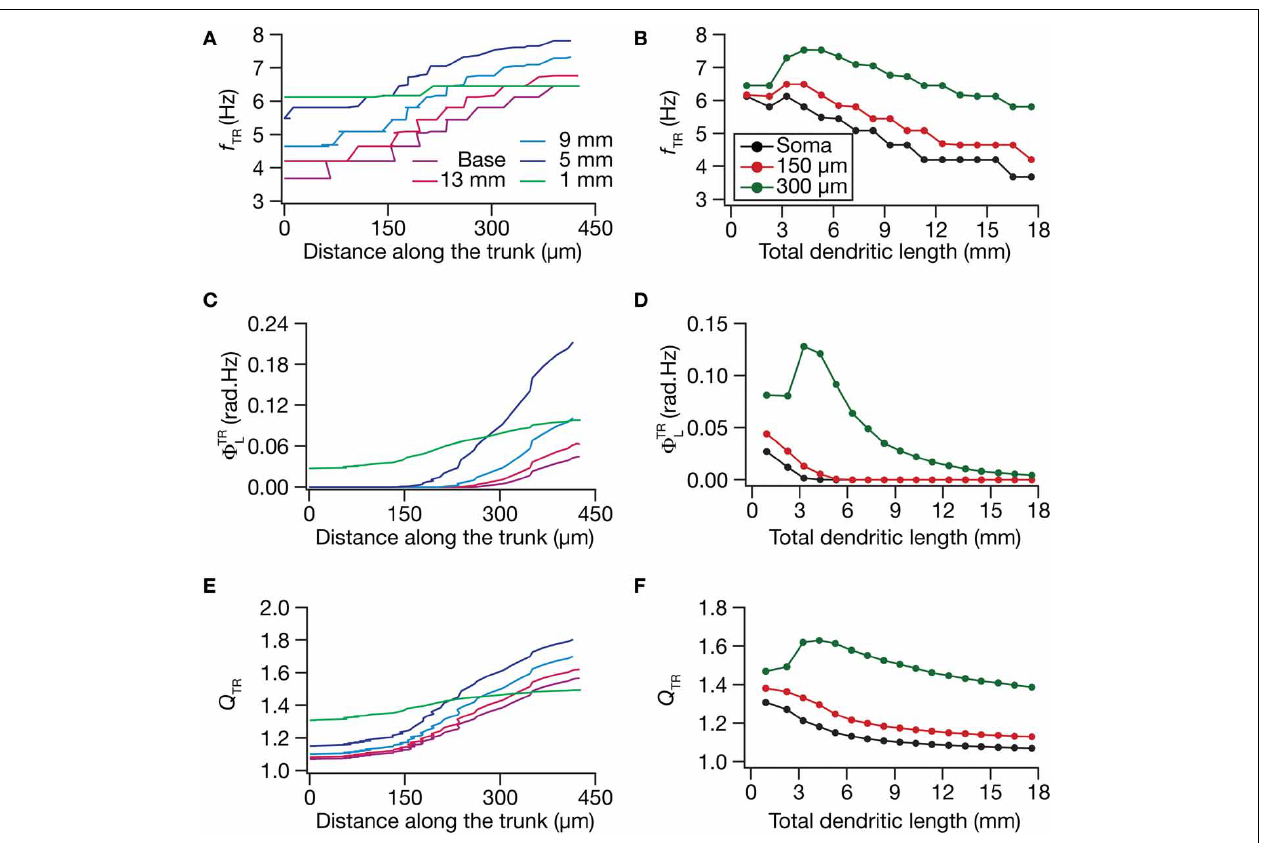
FIGURE 6 | Functional maps of several HCN - channel-dependent transfer impedance measurements were critically regulated by dendritic atrophy. (A,B) Transfer resonance frequency ( f TR ) plotted as functions of distance from the soma ( A ; for 5 different pruned morphologies, Figure 1A ) and total dendritic length ( B ; for 3 distinct